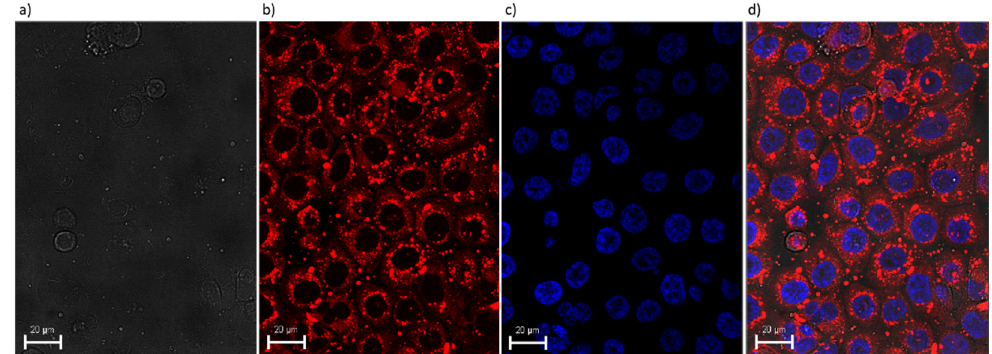
Figure 4. Visualization of the intracellular uptake of Nile Red loaded liposomes by BxPC3 pancreatic cancer cells. Transmitted light ( a ), Nile Red fluorescence signal (red) ( b ), DAPI fluorescence (blue) ( c ) and the merged ( d ) image of cells observed after 2 h incubation with labeled liposomes. Scale bar = 20 µm